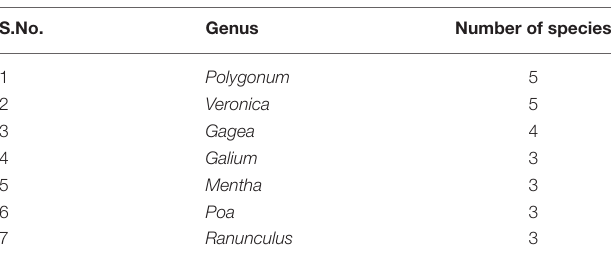
TABLE 4 | Most representative genera.